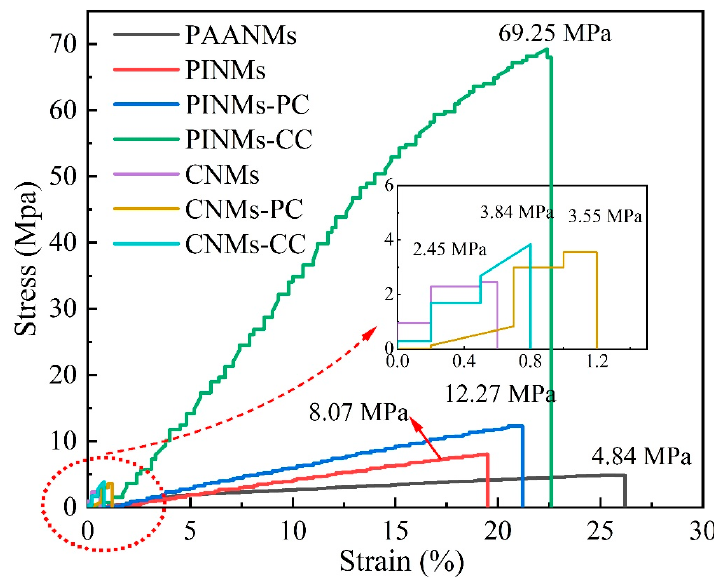
Figure 6. Stress–strain curves of samples.